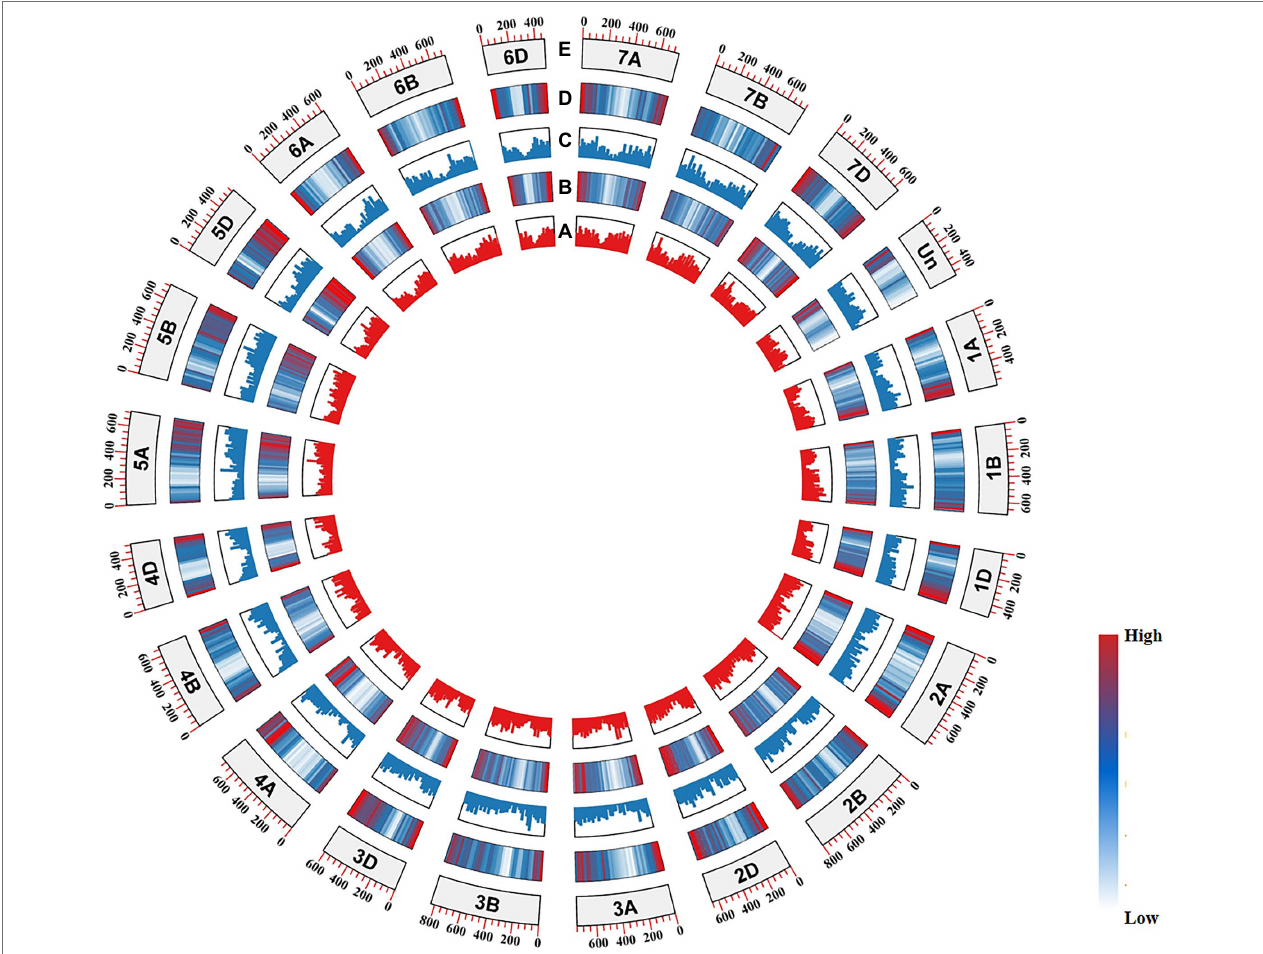
FIGURE 4 | CIRCOS visualization of various Triticum aestivum genome data. (A) Median GC3 values for genes from the (+) strand. (B) Gene density of the (+) strand. (C) Median CG3 values for genes from the ( − ) strand. (D) Gene density of the ( − ) strand. (E) Chromosome name and